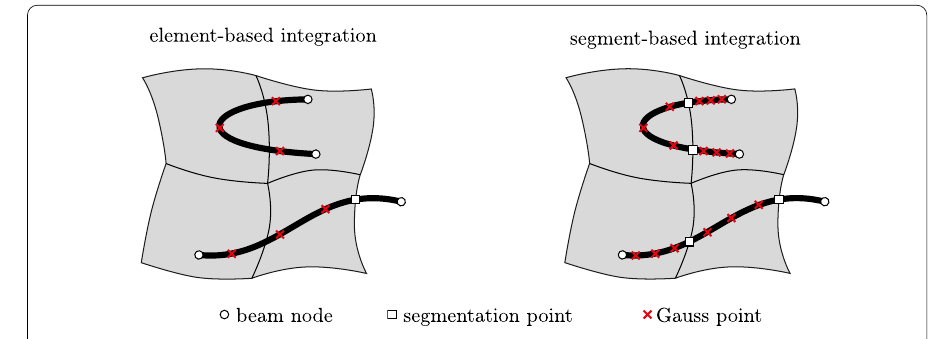
Fig. 4 Segmentation of the beam element for stable and accurate numerical integration as presented in [24]: circles and crosses denote beam nodes and quadrature points, respectively. The squares subdivide the beam into integration segments, such that an integration cell on the beam does not cross element boundaries of the fluid mesh to not integrate across weak